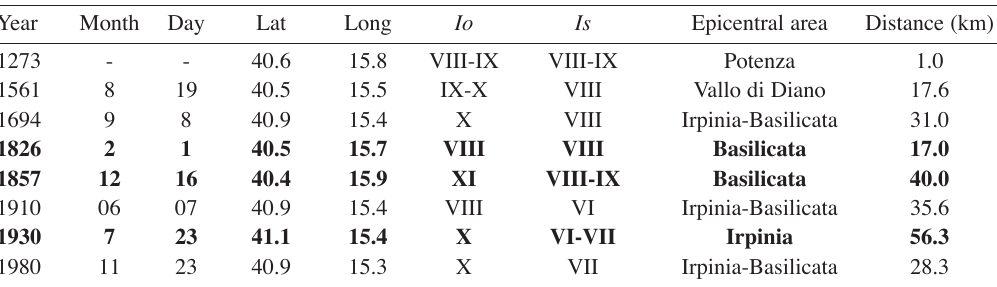
Fig. 1. Strongest historical earthquakes that affect- ed Potenza. The circle diameter is proportional to the epicentral intensity (MCS). The black circles show the seismic events analysed in this paper. Data are drawn from Boschi et al. (2000). Table I. Strongest earthquakes felt in Potenza. In bold the earthquakes analysed in this paper. Events are ex- tracted from Boschi et al. (2000). Io = epicentral intensity (MCS); Is = intensity in Potenza